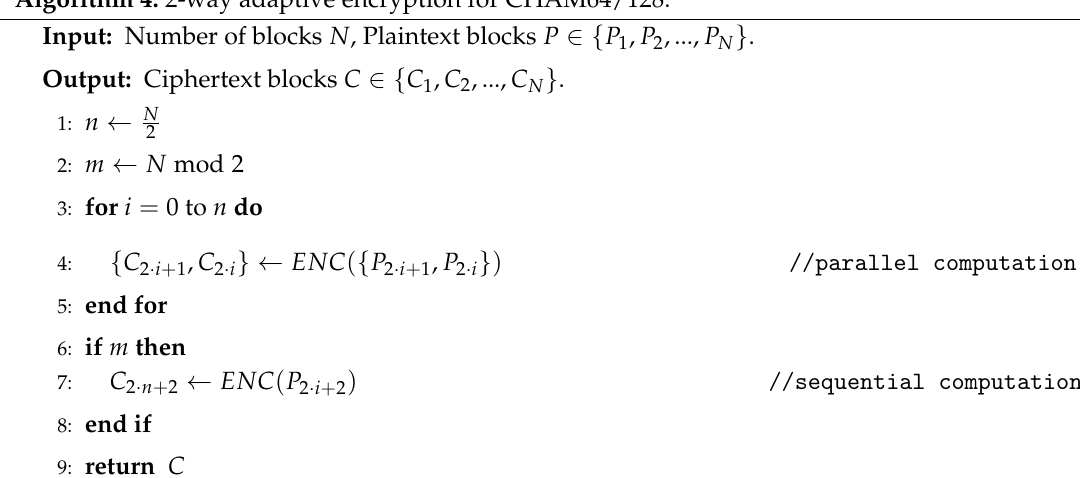
Algorithm 4: 2-way adaptive encryption for